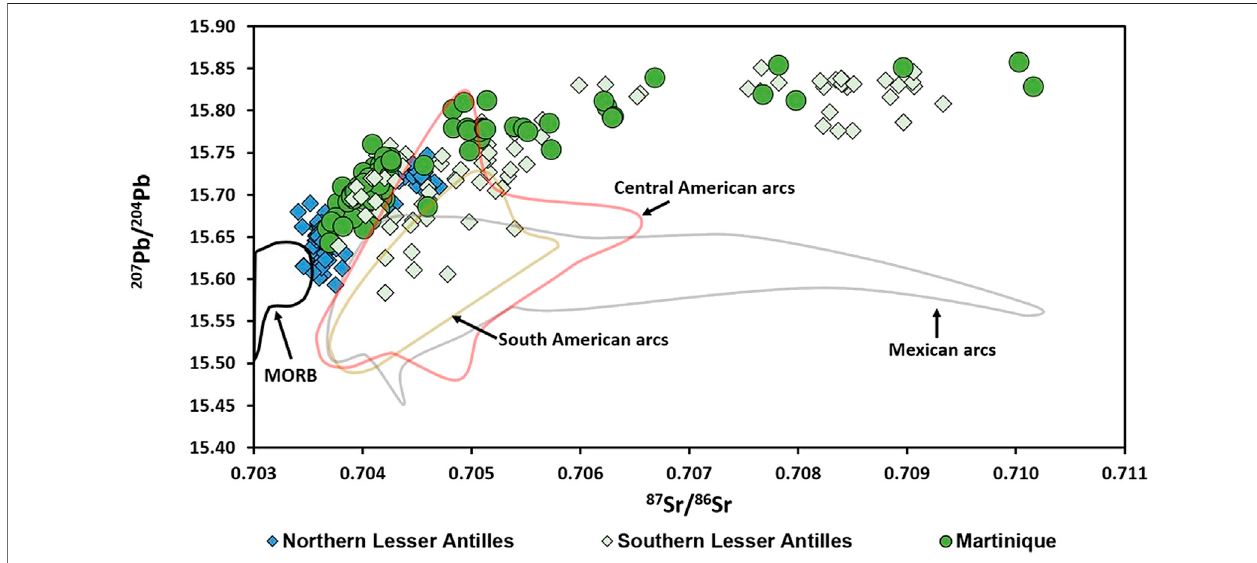
FIGURE 2 | 87 Sr/ 86 Sr vs. 207 Pb/ 204 Pb of lavas from the Lesser Antilles arc, compared to nearby arcs from Central-South America shown in Figure 1 . For all data points, uncertainty (2 SE) is smaller than symbol size. Northern Lesser Antilles (cid:1) Saba to Dominica. Southern Lesser Antilles (cid:1) Martinique to Grenada (Martinique data shown separately). Data sources: Northern Lesser Antilles — Van Soest et al. (2002); Lindsay et al. (2005); Toothill et al. (2007); DuFrane et al. (2009); Davidson and Wilson (2011). Southern Lesser Antilles – Thirlwall and Graham (1984); Davidson (1986); White and Dupre (1986); Smith et al. (1996); Thirlwall et al. (1996); Turner et al. (1996); Heath et al. (1998); Labanieh et al. (2010); Huang et al. (2011); Bezard et al. (2014). Southern American, Central American and Mexican arc data from the Georoc database (http://georoc.mpch-mainz.gwdg.de/georoc/). MORB data from the PetDB database (www.earthchem.org/petdb) for Mid-Atlantic Ridge basalts 30 ° either side of the equator. Labanieh et al. (2010) found that the difference between measured and age corrected isotope ratios for the oldest lavas in the arc ( ∼ 25 Ma, fromMartinique)wasnegligible.SincemajorityoflavasintheLAAaremuchyoungerthan25 Ma,agecorrectionisconsiderednegligiblebymajorityofauthorsandwould not alter the trend shown.